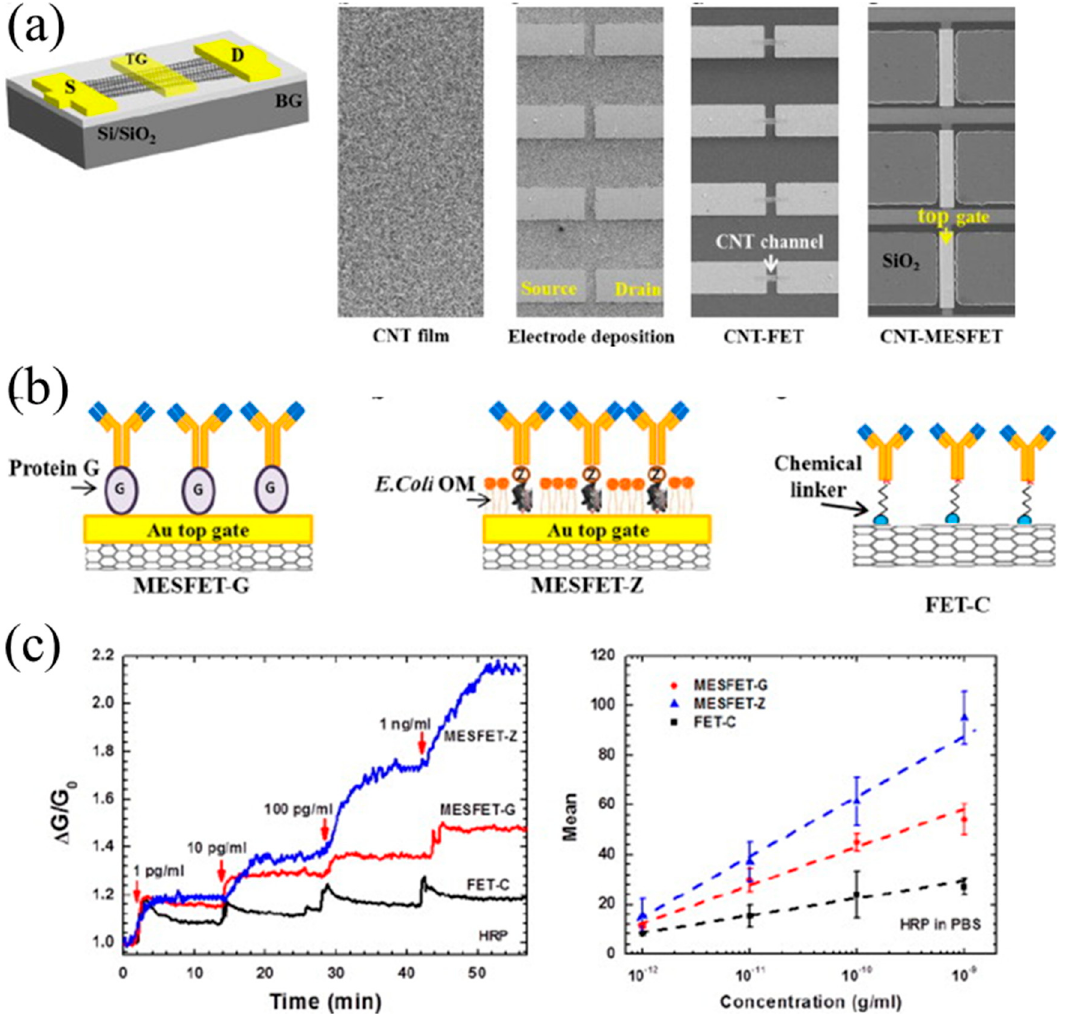
Figure 8. ( a ) Sketch of metal–semiconductor field-effect transistor (MESFET) based sensor and optical micrographs of the carbon nanotube (CNT) film and the procedure to obtain the sensors; ( b ) sketch showing the surface functionalization process and ( c ) measured results of A β biomarker with MESFET sensor. Reproduced from reference [86] with permission from Elsevier.